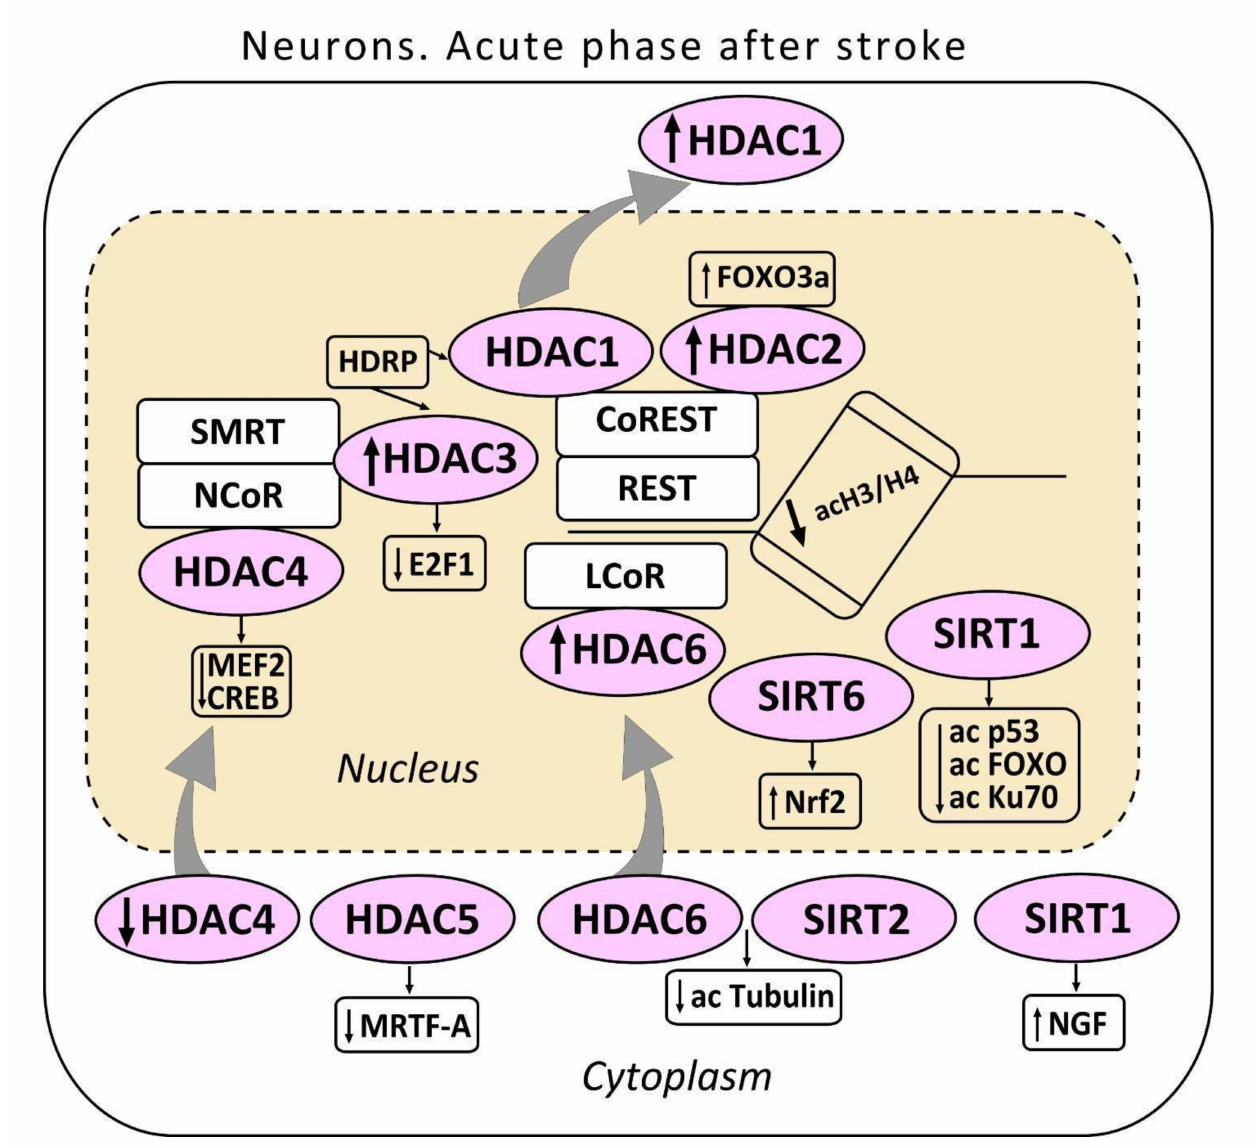
Figure 1. The acute phase after stroke in the neuron. The localization of histone deacetylases (HDAC 1-6) including sirtuins (SIRT 1,2) in the cell is shown. HDAC3 and HDAC1 interact with histone deacetylase-related protein (HDRP), a shortened form of HDAC9. HDRP inhibited the HDAC1/HDAC3 interaction. HDAC1 and HDAC2 are included in the repressor element-1 silencing transcription factor (REST) corepressor 1 (CoREST) complex. HDAC3 in the nuclear receptor co-repressor (NCOR)/silencing mediator for retinoid or thyroid-hormone receptors (SMRT) complex suppresses the production of the pro-apoptotic transcription factor E2F1. HDAC4 suppresses the activity of myocyte enhancer factor 2 (MEF2) and cAMP response element-binding protein (CREB). HDAC4 interacts with the co-repressor complex HDAC3/NCOR. HDAC5 suppressed myocardial transcription factor-A (MRTF-A). One of the cytoplasmic substrates of HDAC6 - α -tubulin is shown. SIRT1 deacetylates p53, FOXO, and Ku70 proteins. The cytoplasmic SIRT1 induces nerve growth factor NGF. SIRT6 stimulates the nuclear factor erythroid 2–related factor